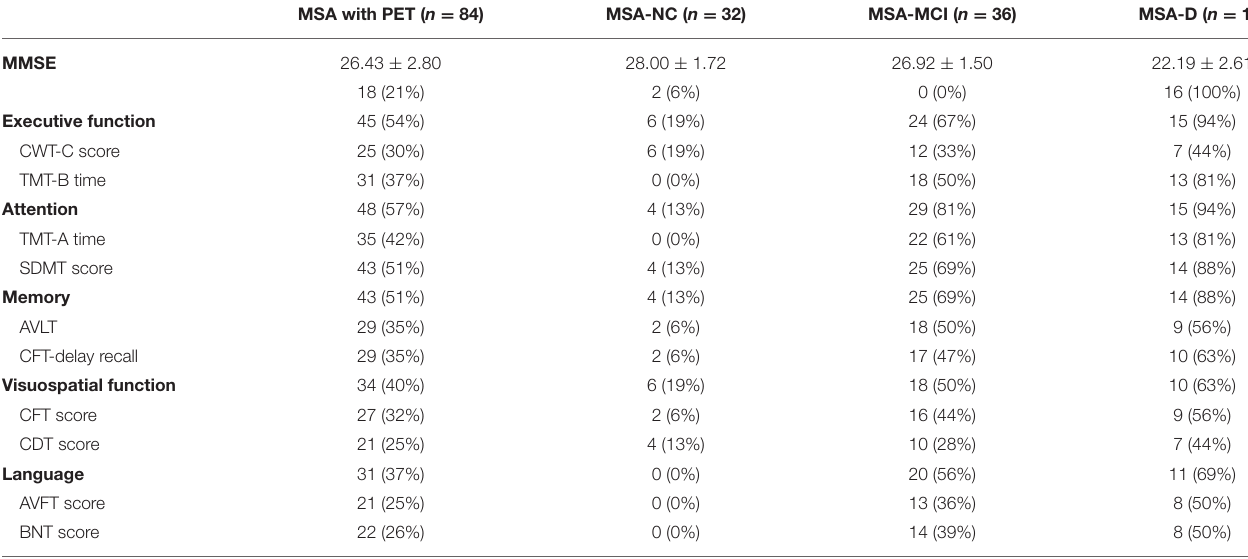
TABLE 2 | Comparisons of cognitive impairment in the three cognitive statuses of 84 MSA patients with PET imaging.